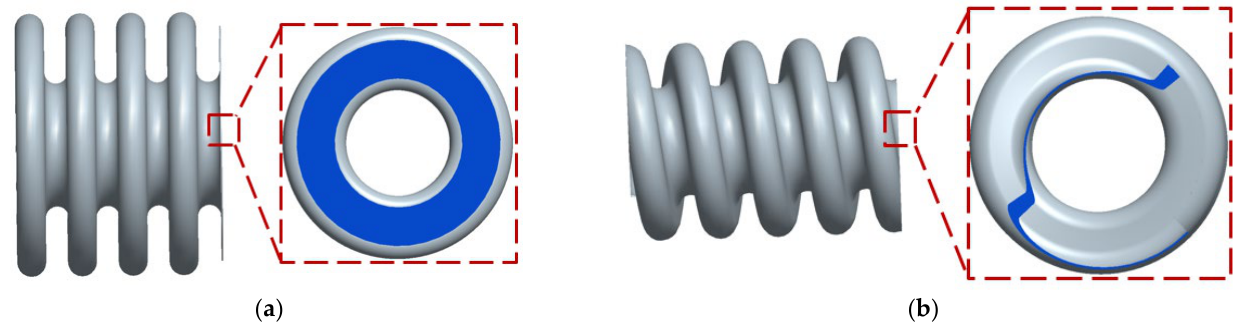
Figure 10. Cross-section of toroid and spiral bellows; ( a ) cross-section of toroid bellows and ( b ) cross-section of spiral bellows.